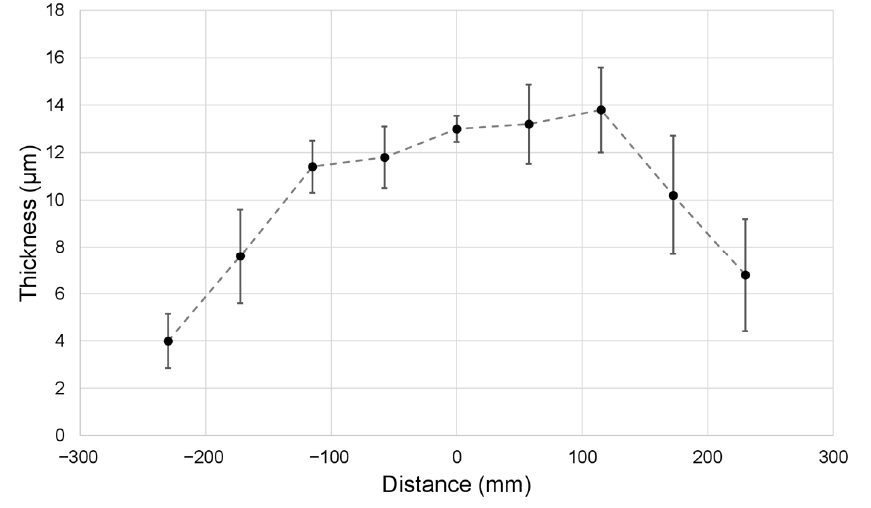
Figure 4. Thickness along the width of the membrane produced with initial setup (without auxiliary electrodes); the dashed line is only a guide for the eyes.